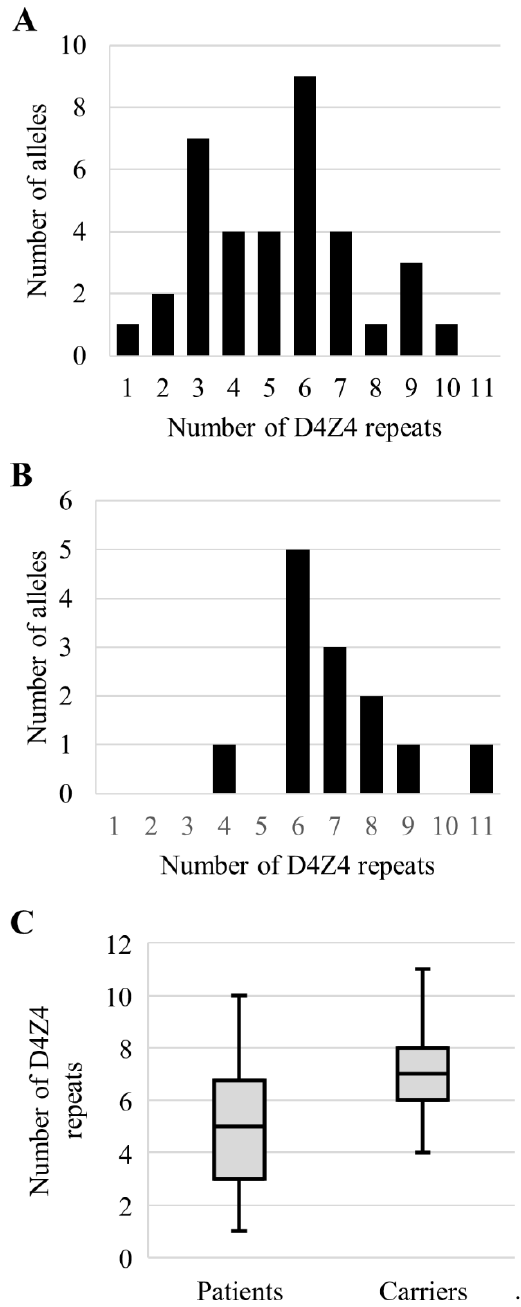
Figure 4. D4Z4 array size distributions. Permissive alleles size distribution among affected individuals ( A ), phenotypically healthy relatives ( B ). ( C ) Comparison of the alleles distribution in groups of patients and phenotypically healthy carriers (z-score = − 2.56, p = 0.01).